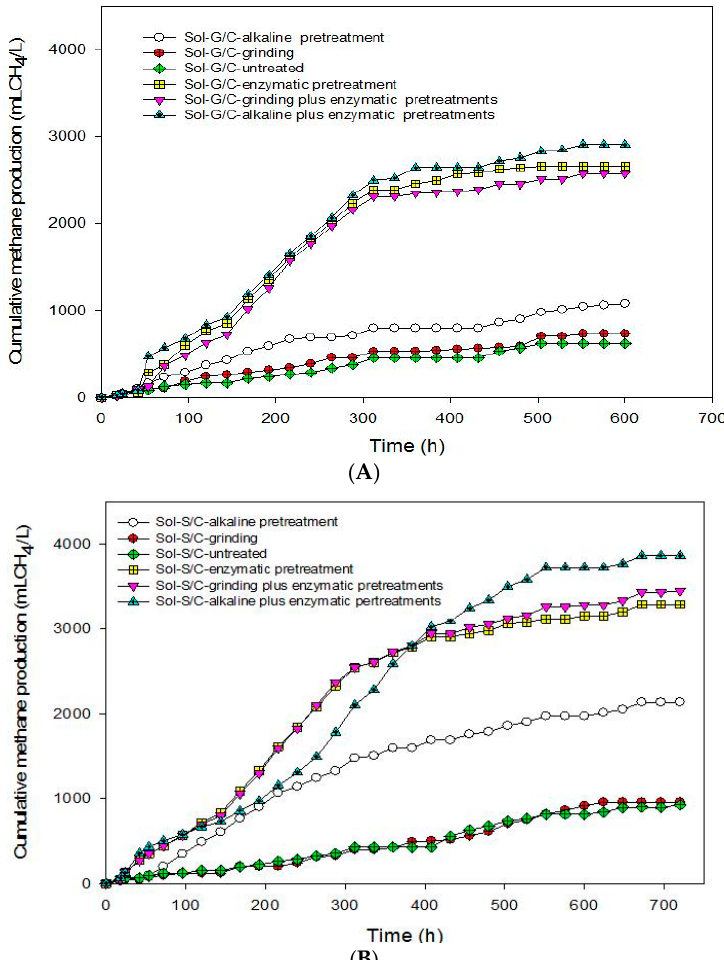
Figure 4. Cumulative methane production profiles of solid residues from a co-digestion of grass with cow dung (Sol-G/C) ( A ) and silage with cow dung (Sol-S/C) ( B ) subjected to different pretreatment methods. Table 6. MP, Rm, MY of pre-treated solid residues from one-stage methane production. Treatment